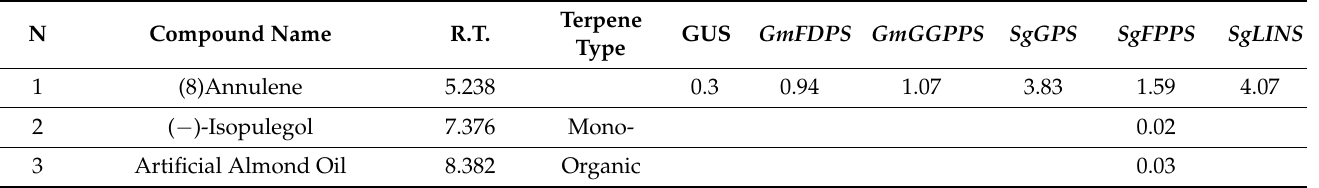
Figure 1. Effects of terpenoid gene overexpression on root and shoot growth. ( A ) Representative photos of chimerical G. max plants with transgenic hairy roots overexpressing terpene synthesis genes. Chimerical soybean plants were generated by transformation with K599 harboring terpene genes including (left to right), GUS (control), GmFDPS, GmGGPPS, SgGPSS, SgFPPS and SgLINS . ( B ) In vivo hairy roots’ fresh weight (gram) and root length (cm). Root phenotypes were examined for at least 10 independent lines ( n = 10). Each column represents the mean ± SD of the parameter and statistical significance was based on the Student’s t -test (* p < 0.05; ** p < 0.01) with GUS-overexpressing hairy roots as control. Table 1. The major chemical composition and terpenes from transgenic